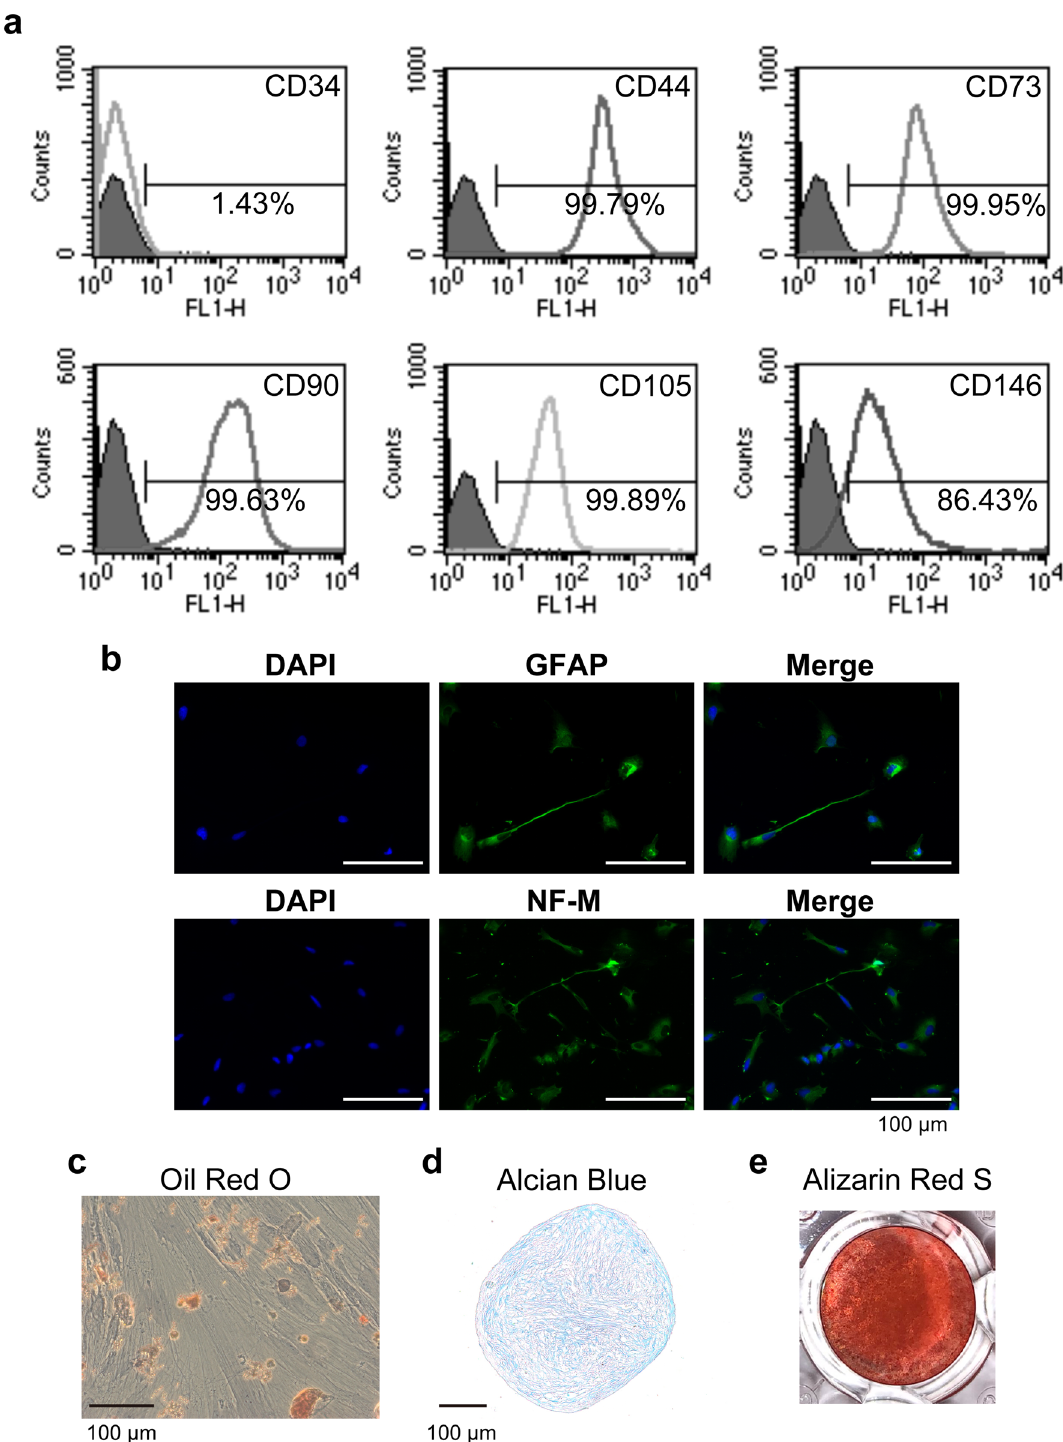
Figure 1. hDPSCs express typical mesenchymal stem cell (MSC) markers and exhibit multi-differentiation potential. ( a ) Typical MSC markers (CD44, CD73, CD90, CD105, CD146) are highly expressed in hDPSCs, and hDPSCs are mostly negative for a hematopoietic marker (CD34). hDPSCs possess neurogenic, adipogenic, chondrogenic, and osteogenic differentiation potential, as determined by the expression of neurogenic markers (GFAP and NF-M) ( b ) the presence of lipid droplets stained by Oil Red O ( c ), chondrogenic glycosaminoglycan accumulation demonstrated by Alcian Blue staining ( d ), and formation of mineralized nodules detected by Alizarin Red S ( e ), respectively. Bars: 100